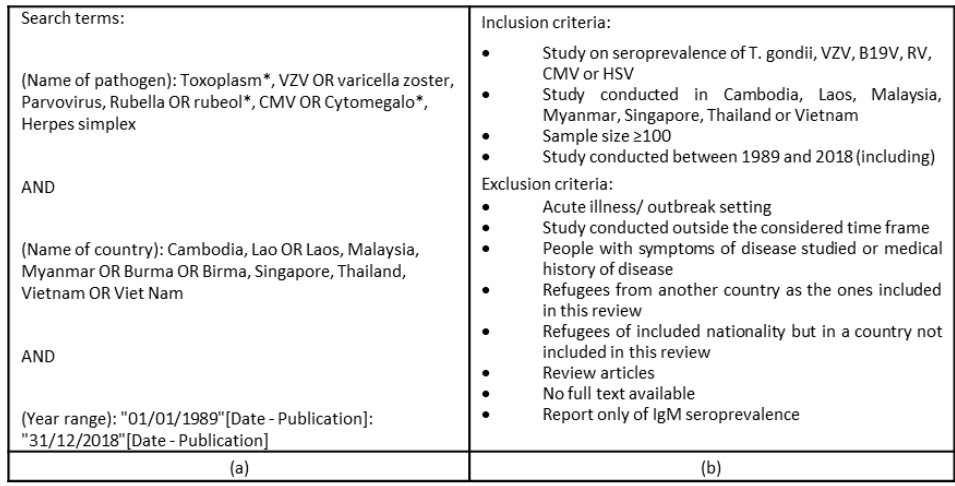
Figure 1. ( a ) PubMed search terms; ( b ) Inclusion and Exclusion criteria for the literature review.